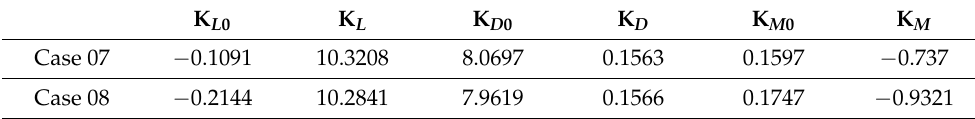
Table 3. Values of Ks for Case 07 and Case